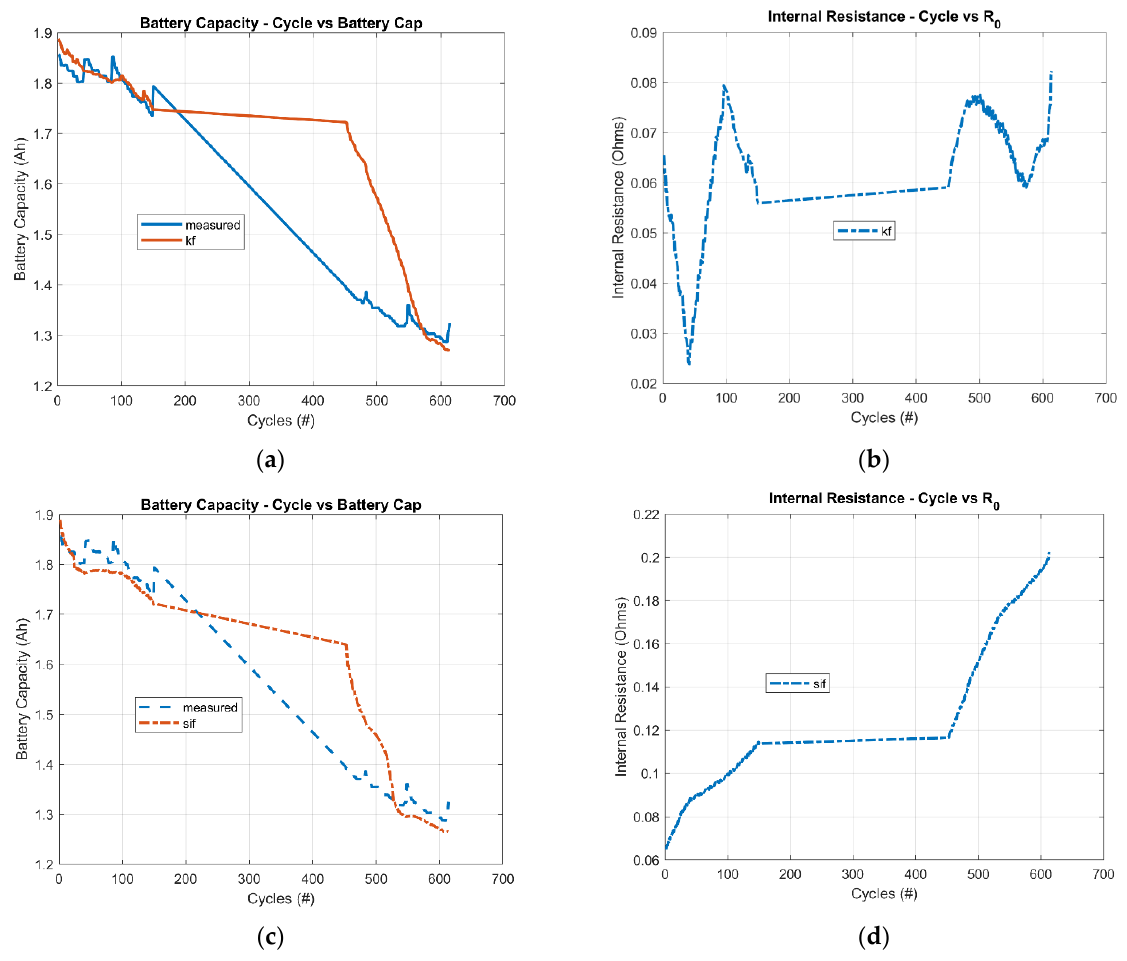
Figure 10. ( a ) Dual-KF Battery Capacity Estimation. ( b ) Dual-KF Internal Resistance Estimation. ( c ) Dual-SIF Battery Capacity Estimation. ( d ) Dual-SIF Internal Resistance Estimation.